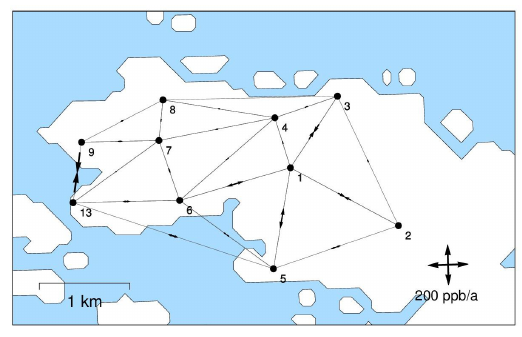
Figure 8. Strains along baselines in the inner network.